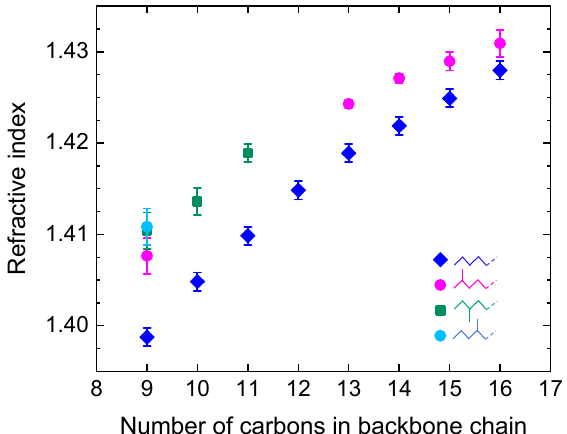
Figure 20. Refractive index at 1 THz (at 20 °C) of alkane compounds with different numbers of carbon atoms in their backbone chain, for both linear and branched compounds, showing the dependence on the carbon number and branching. Adapted from [133].